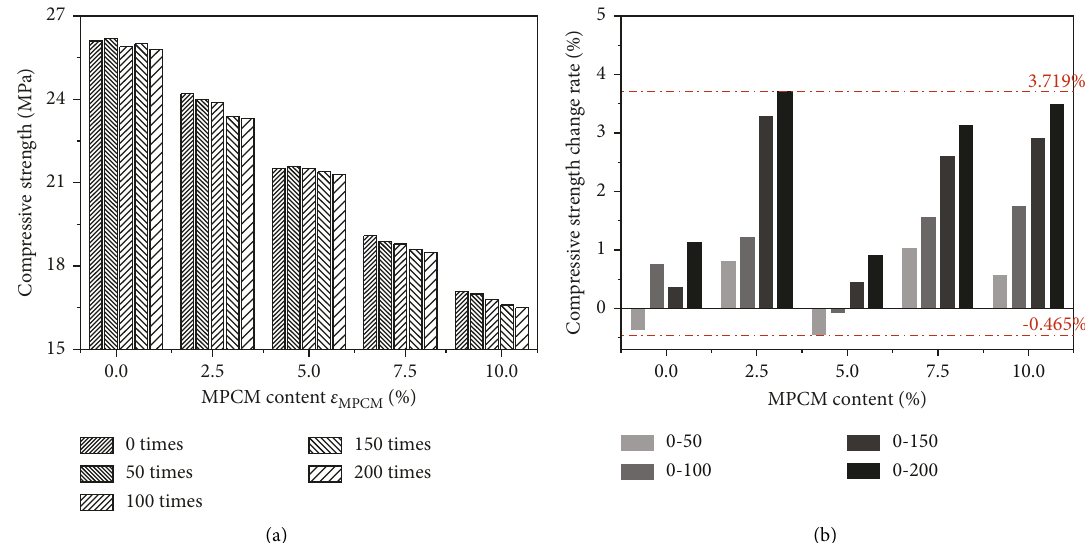
Figure 7: The relation curve between the numbers of phase-change cycle and compressive strength with the numbers of phase-change cycle. (a) The change law of compressive strength. (b) The change law of compressive strength variation.